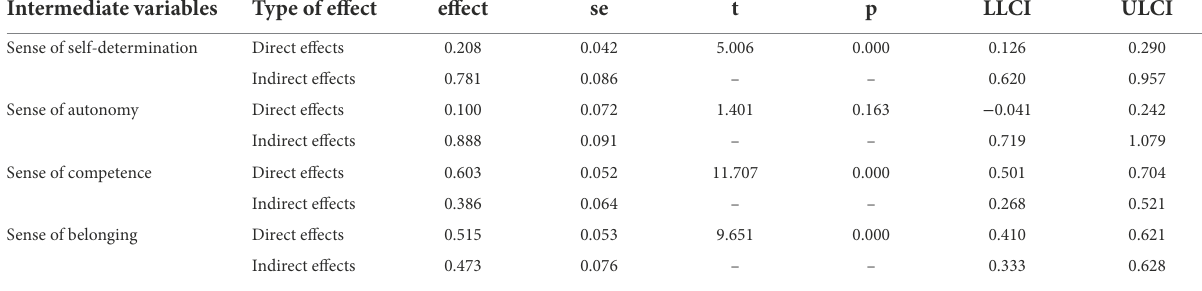
TABLE 2 Mediating effects of self-determination and its